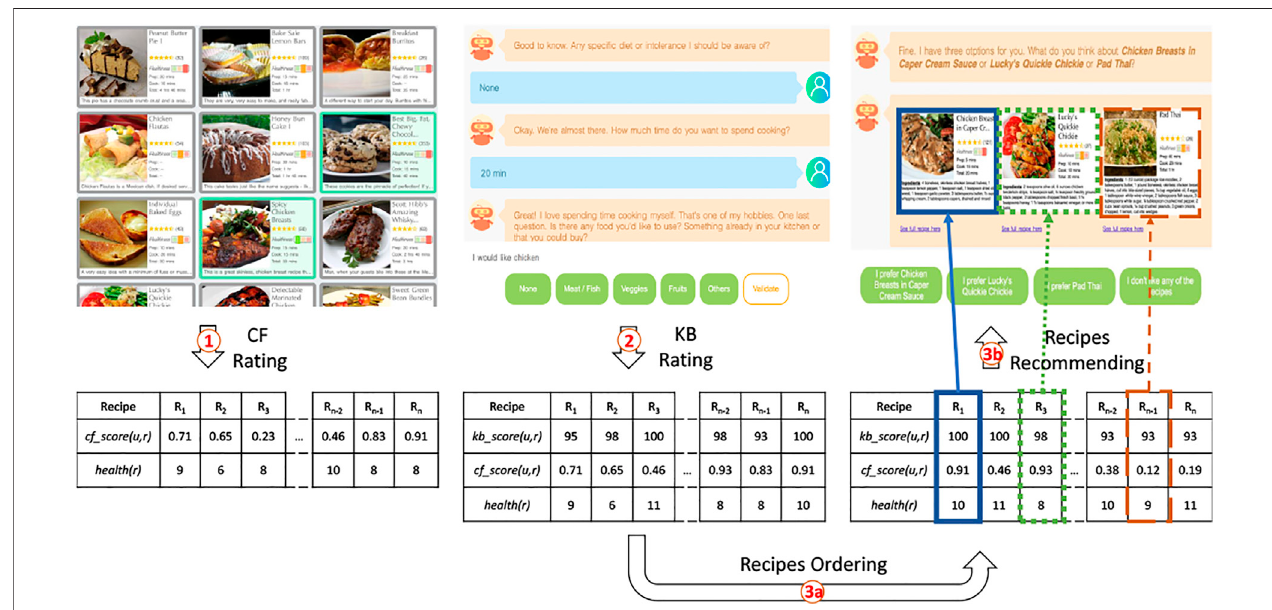
FIGURE4| OverviewoftherecommendationProcess.Auser u fi rstselectsrecipeshelikesfromalistofrecipes.Thesystemreliesonthisuserpro fi letocomputea cf _ score ( u , r ) for each recipe r as explained in Section 6.1.1 . The system then asks about user ’ s u speci fi c constraints and computes a kb _ score ( u , r ) as explained in Section 6.1.2 . The system then orders the recipes according to their scores before delivering a recommendation to the user.